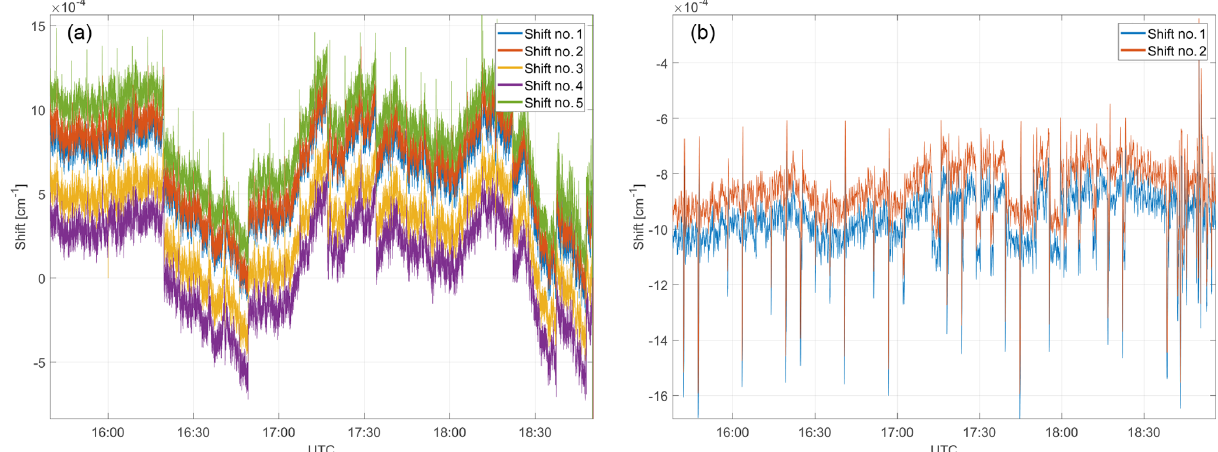
Figure 8. Spectral shifts for the CH 4 –H 2 O fit window (a) and the CO 2 –CO–N 2 O fit window (b) . Spectral stability during ground-based operation is in the range of ± 10 − 3 cm − 1 .